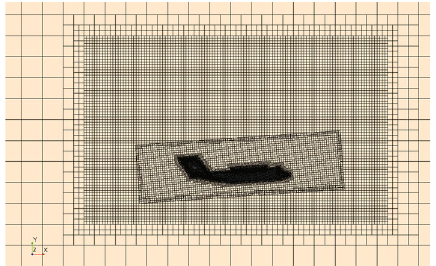
Figure 7: Mesh on aircraft symmetry plane.